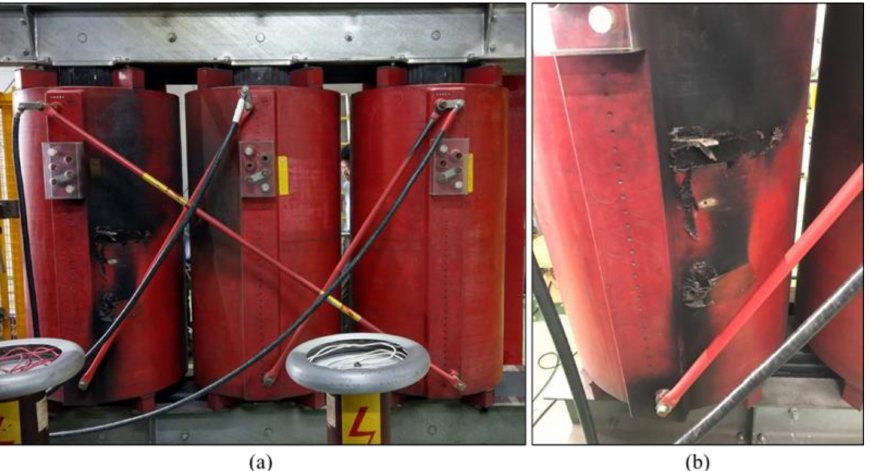
Figure 20. ( a ) Transformer. R, S, and T from right to left. ( b ) A close-up of the details of the T-phase fault.